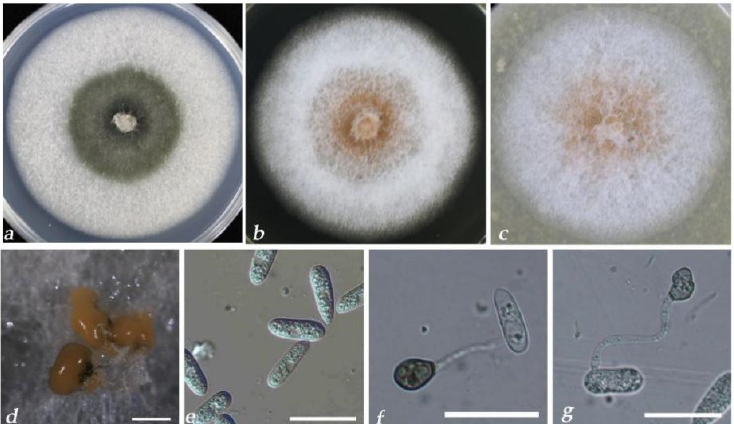
Figure 6. Culture characteristics and microscopic features of C. pseudoacutatum HZJ-6. ( a – c ) Seven- day-old of colonies on PDA, MEA, and OA medium, respectively. ( d ) Conidiomata. ( e ) Conidia. ( f , g ) Appressoria. Scale bars: ( d ) = 500 μ m; ( e , f ) = 20 μ m. Table 1. Colony morphology and morphometry of Colletotrichum species recovered form grape.